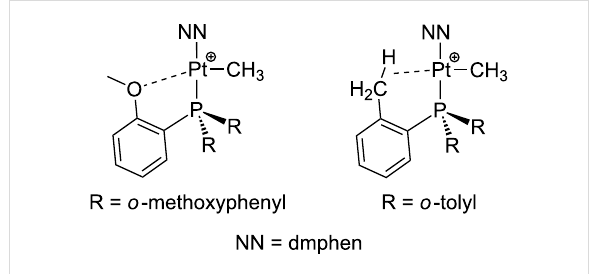
Figure 16: Feasible interactions for unsaturated intermediates 11b (left) and 12b (right) during fluxional motions